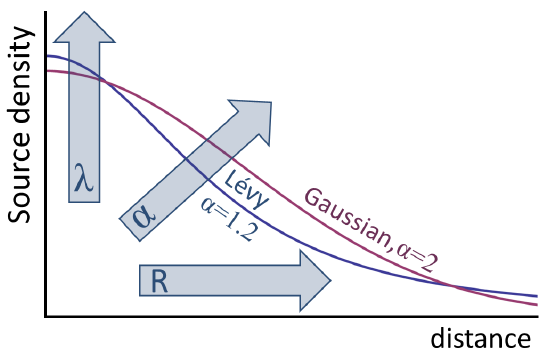
Figure 2. Comparison of the Gaussian and the Lévy distribution with a given α , R and λ . It can be seen that the Lévy distribution has a power-law-like tail.